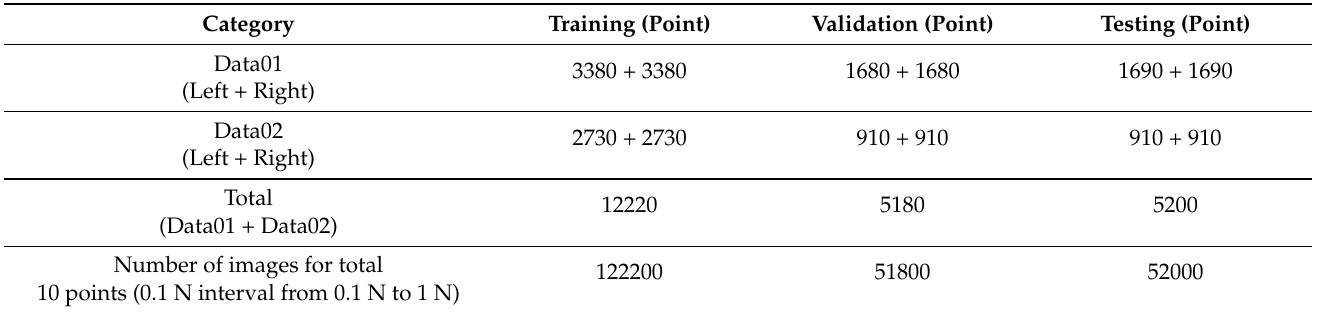
Table 4. Dataset employed for training, validation, and